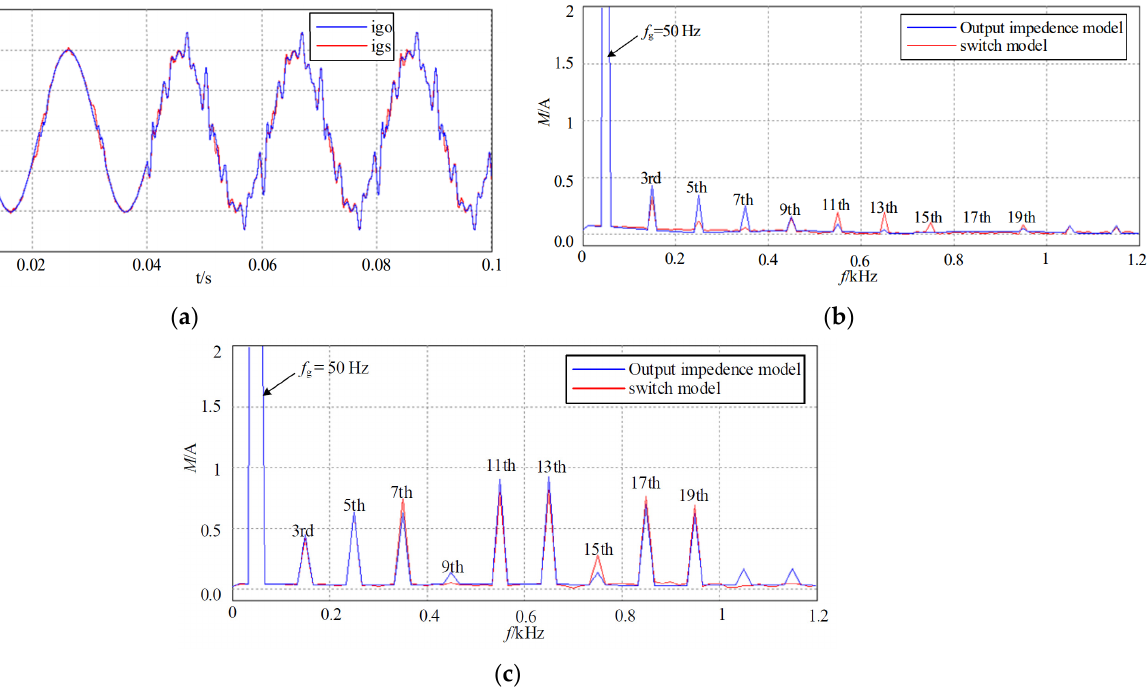
Figure 9. Comparison of grid-connected current between two models of the converter: ( a ) Time domain waveform of grid-connected current of the two models; ( b ) Current spectrum under normal power grid; ( c ) Current spectrum under distorted power grid.